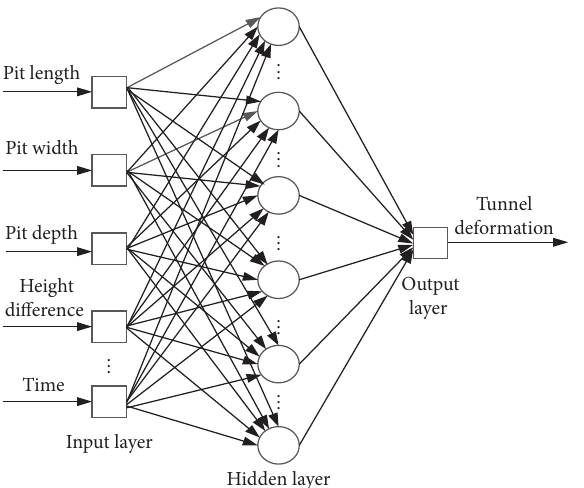
Figure 8: Network topology of the prediction